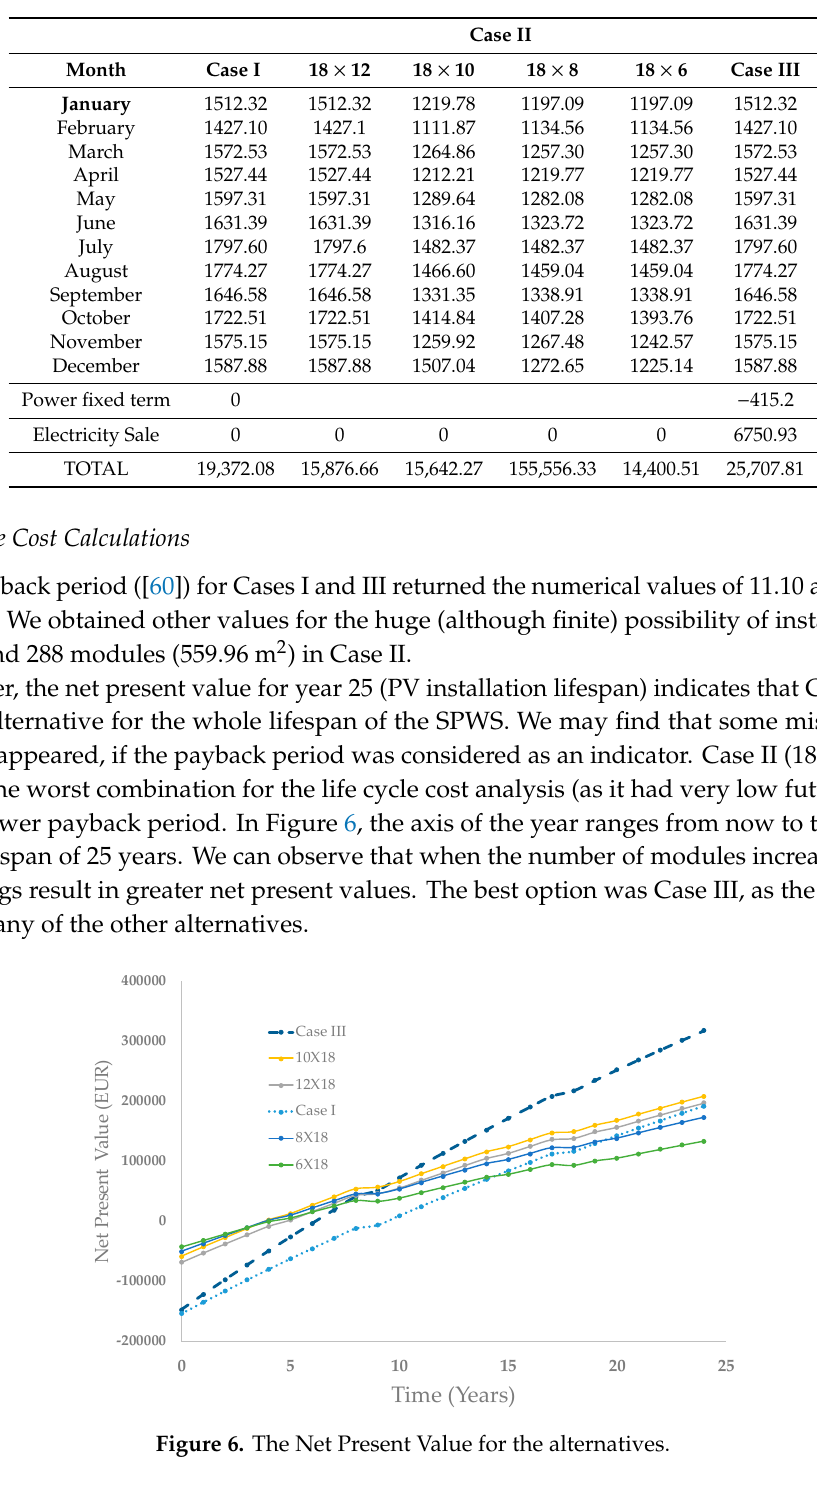
Table 7. Energy savings S i (EUR) for the analyzed cases.